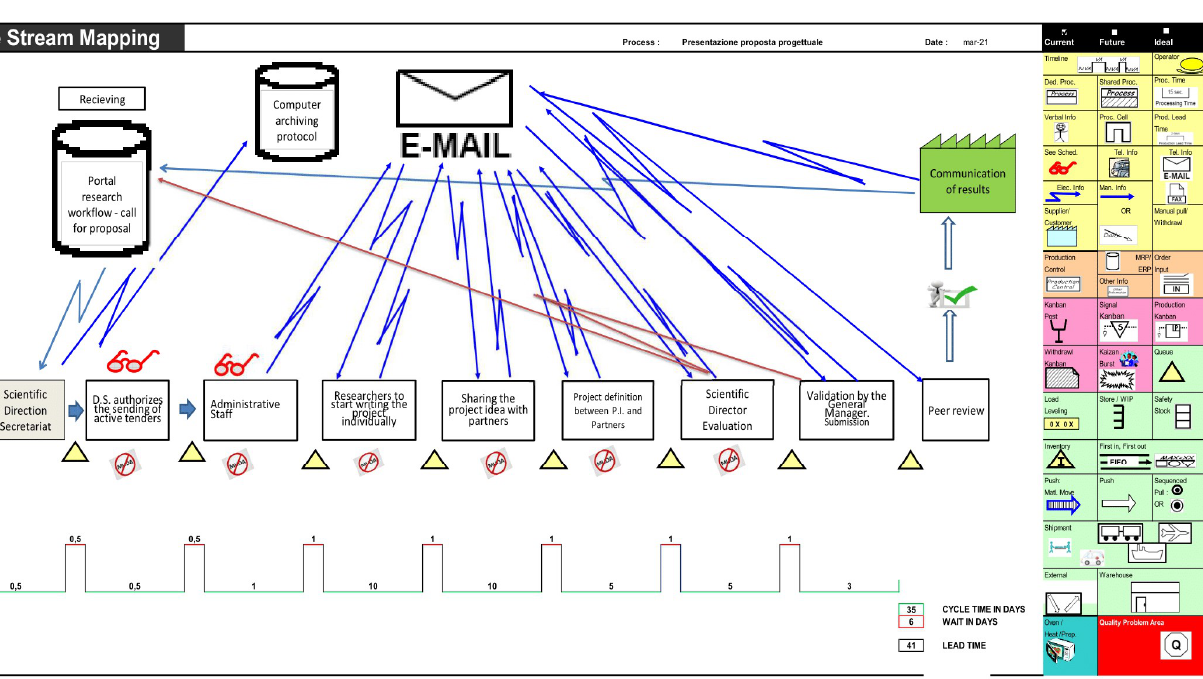
Figure 2. Actual state “AS IS”.